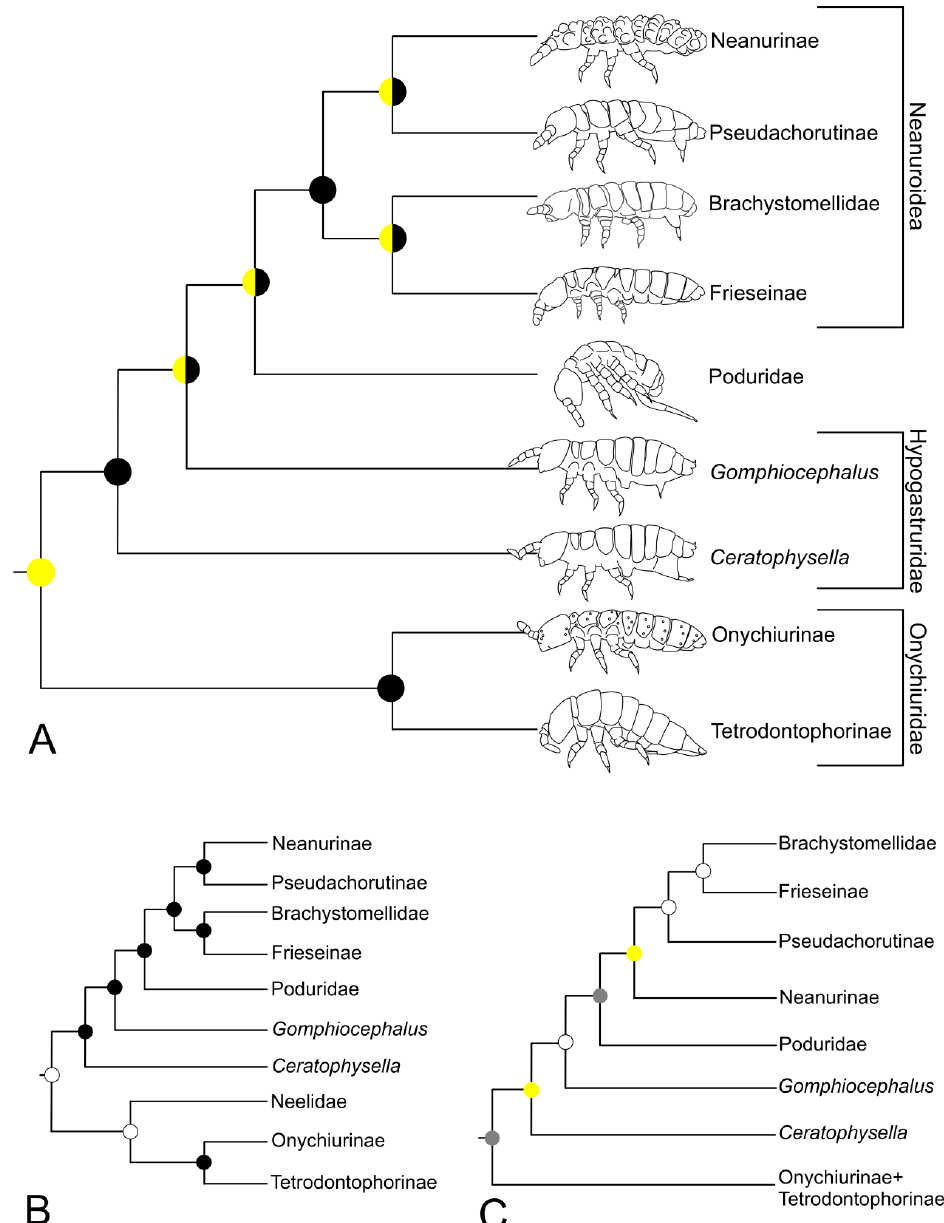
Figure 4. Summarized phylogenetic relationships of the higher Poduromorpha: ( A ) topology of ML_1, ML_2, ML_3 and ML_4 trees (nodes depict only ML_1 support levels); ( B ) topology of BI tree; ( C ) topology of MP tree. Node circles represent SH-aLRT support (left side) and bootstrap values (right side), respectively, for ML tree, posterior probability for BI tree, and maximum parsimony bootstrap for MP tree. Colors represent the following scores: black = 100 (1 for BI); yellow = 95 – 99.9 (0.95 – 0.99 for BI); grey = 90 – 94.9 (0.9 – 0.94 for BI); white < 90 (<0.9 for BI).